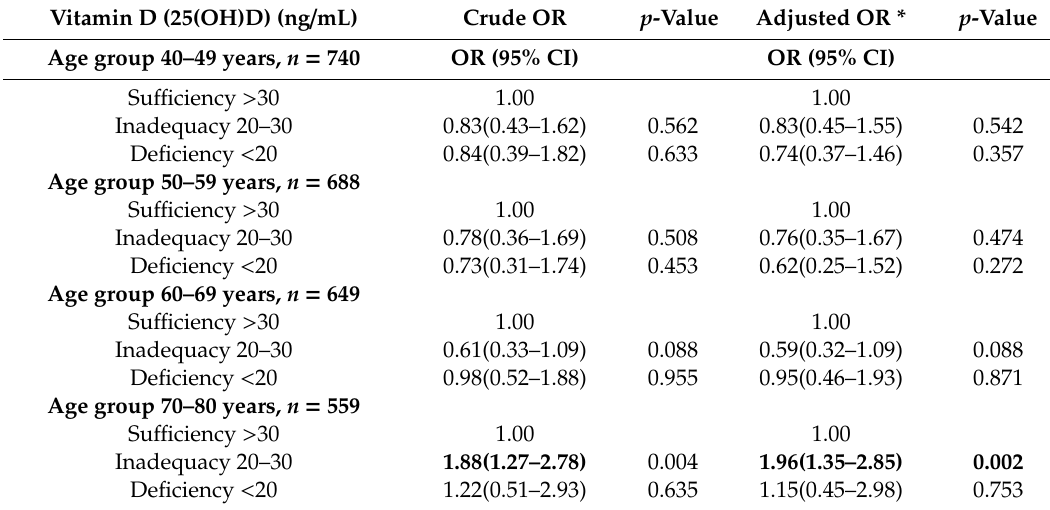
Table 4. Adjusted associations between Vitamin D (25(OH)D) and taste impairment by age groups in American adults ( n = 2636), the NHANES